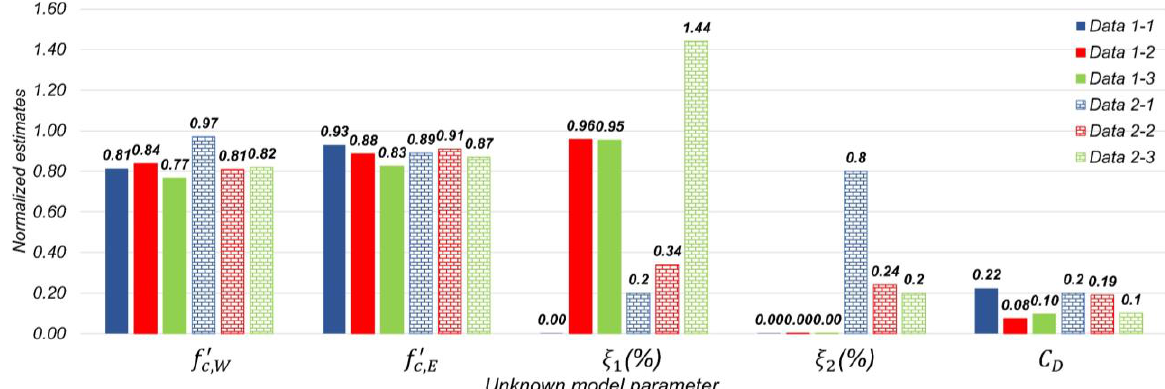
Figure 13. The final estimates of unknown model parameters using data sets in Table 4. The information on each set of data is shown in Table 4. The estimates for parameters 𝑓 𝑐,𝑊′ , 𝑓 𝑐,𝐸′ and 𝐶 𝐷 are normalized to their corresponding initial values in time-domain model updating process.